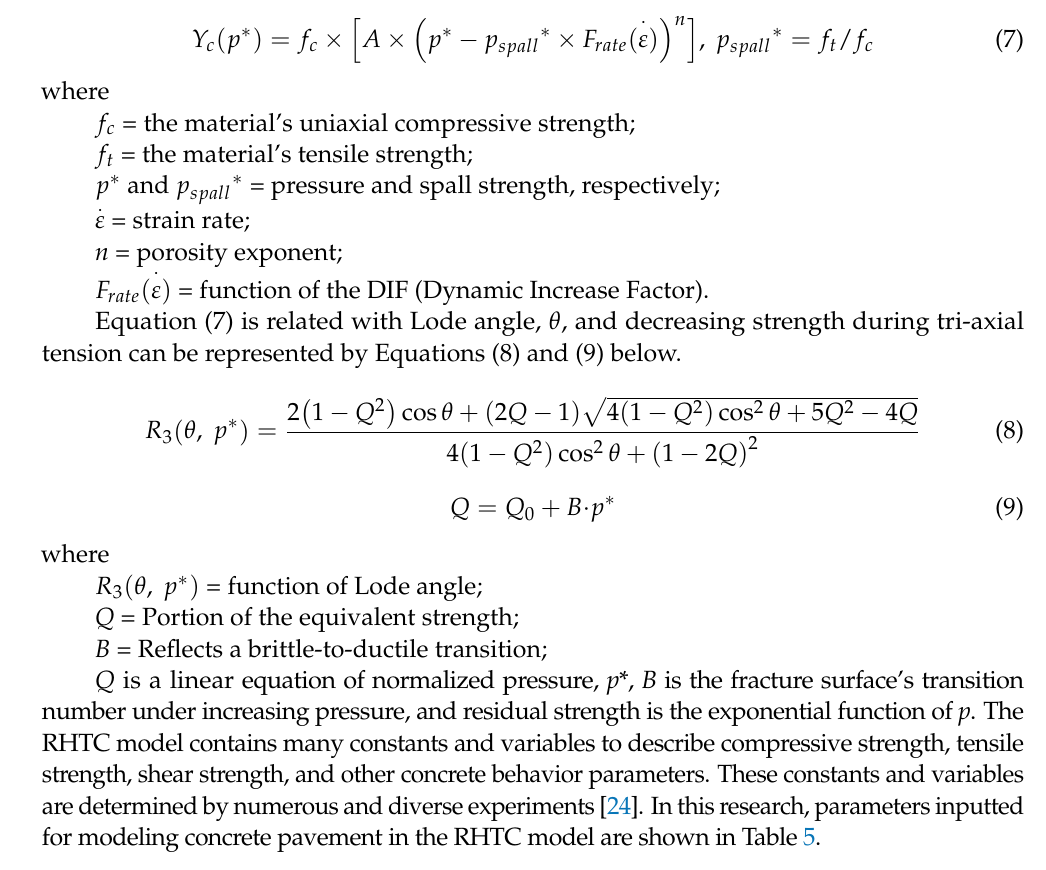
Table 5. RHTC Model Material